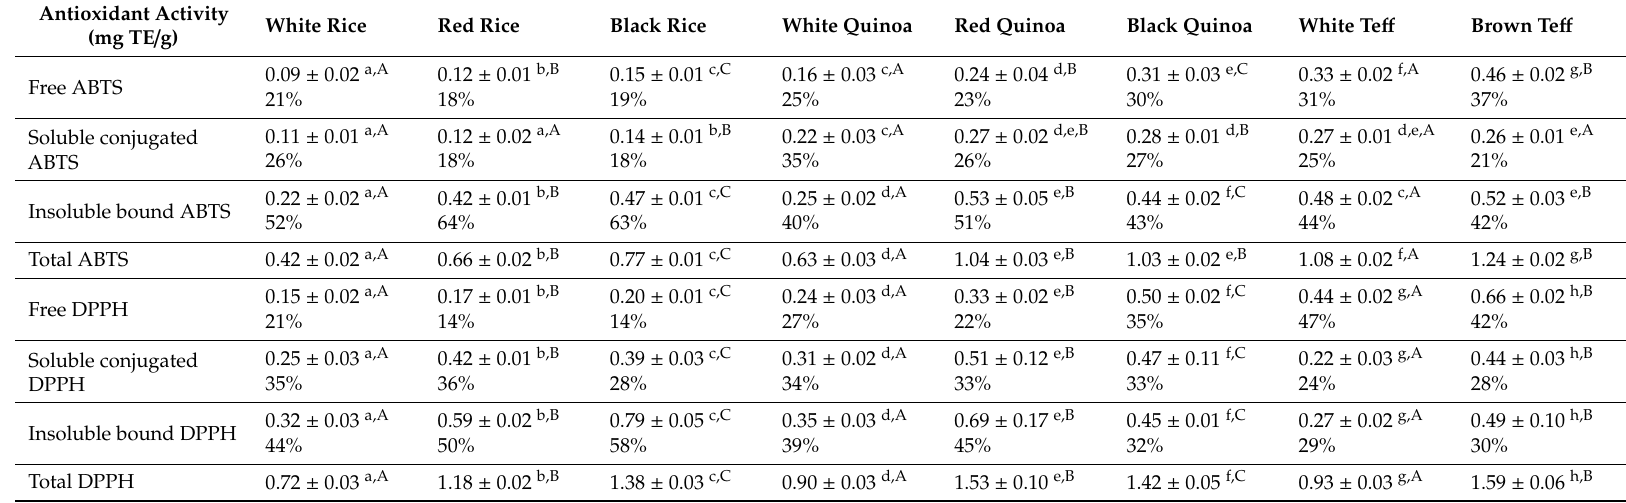
Table 3. Results of antioxidant activity assay in free, soluble and insoluble bound phenolic fractions of non-traditional